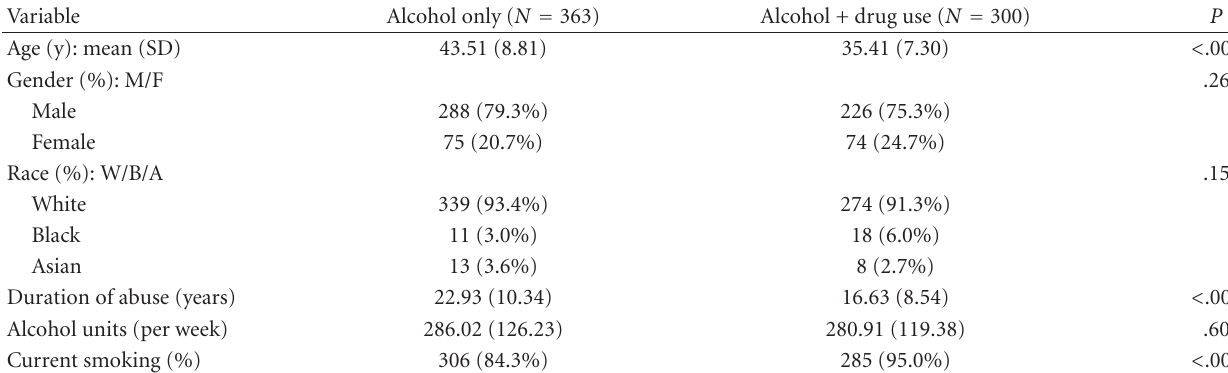
Table 1: Demographic and behavioural characteristics of the study